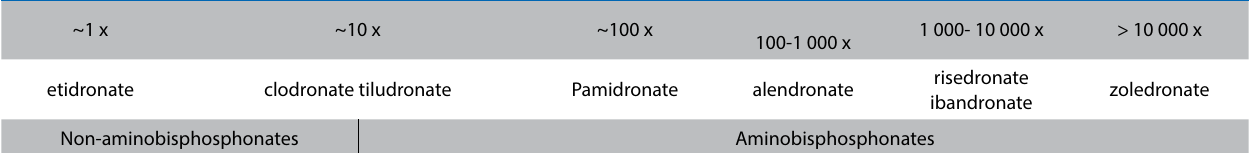
Table XII: Potency of bisphosphonates in inhibiting bone resorption ~1